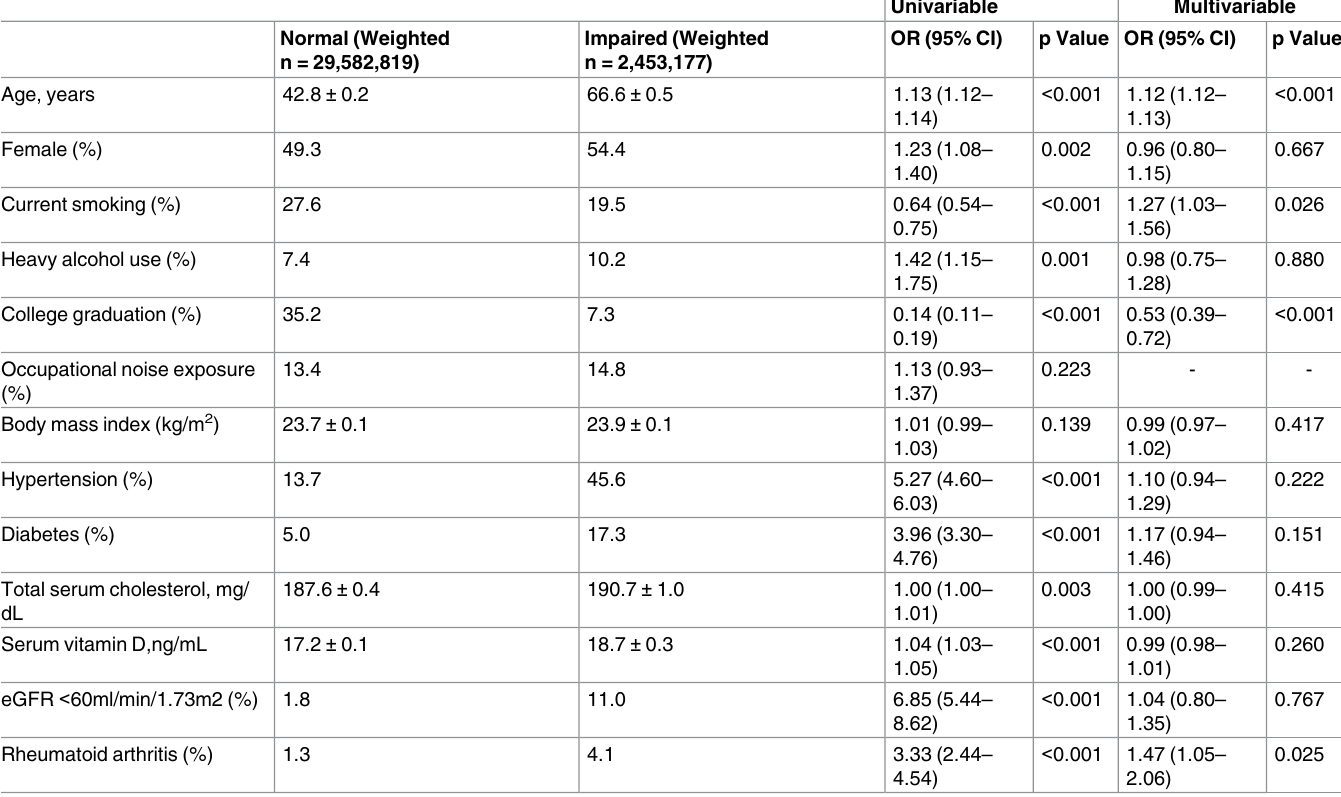
Table 3. Logistic regression analysis to predict risk of low/mid-frequency hearing impairment in the Korean adult